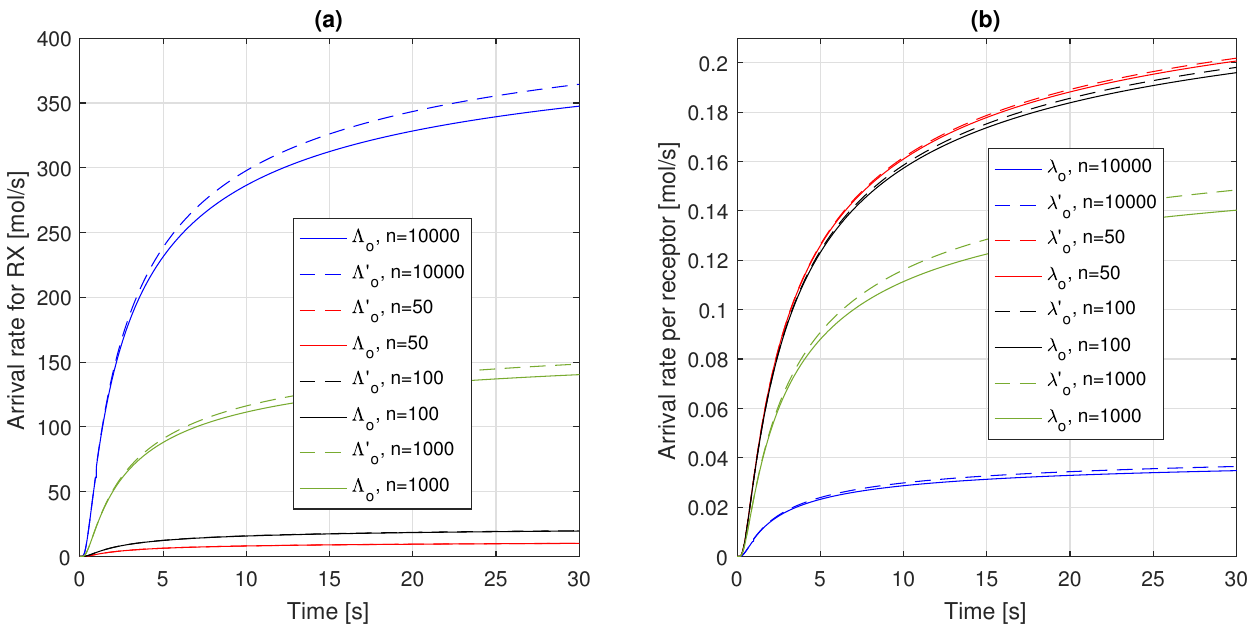
Figure 5. Arrival rates as a function of time for different values of the number of receptors, n : ( a ) Λ (cid:48) o ( t ) and Λ o ( t ) , and ( b ) λ (cid:48) o ( t ) and λ o ( t ) .